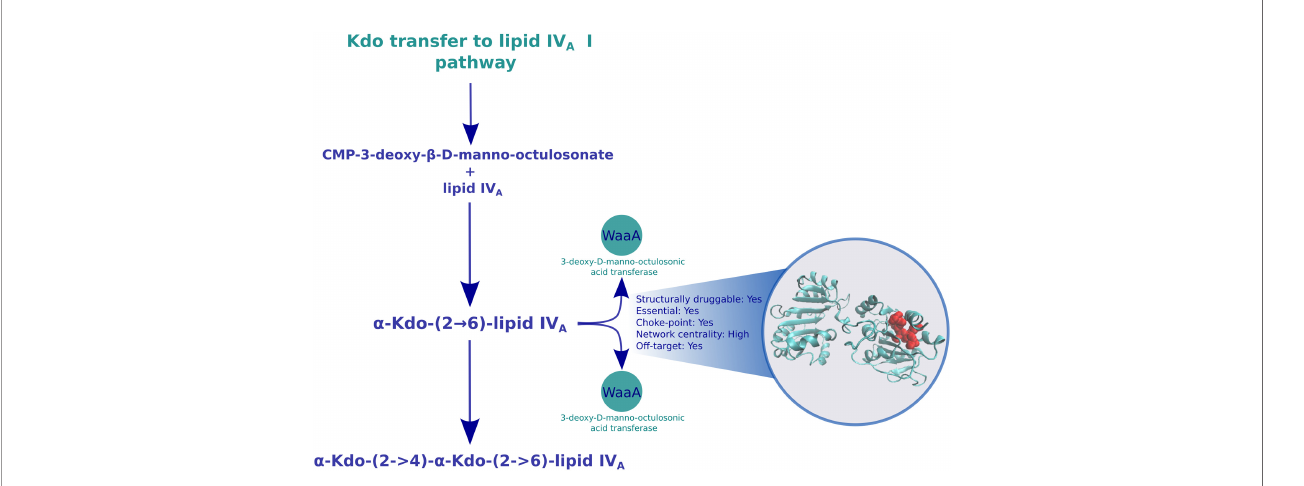
FIGURE 2 | Druggable features of the Kdo transfer to lipid IV A pathway. The structure of the 3-deoxy-D-manno-octulosonic acid transferase in the pathway is shown in cyan, with the predicted binding sites in red. The box next to the structure shows characteristics of this enzymes, such as druggability, essentiality, centrality in the reaction graph, and whether it is found overexpressed during carbapenem exposure.